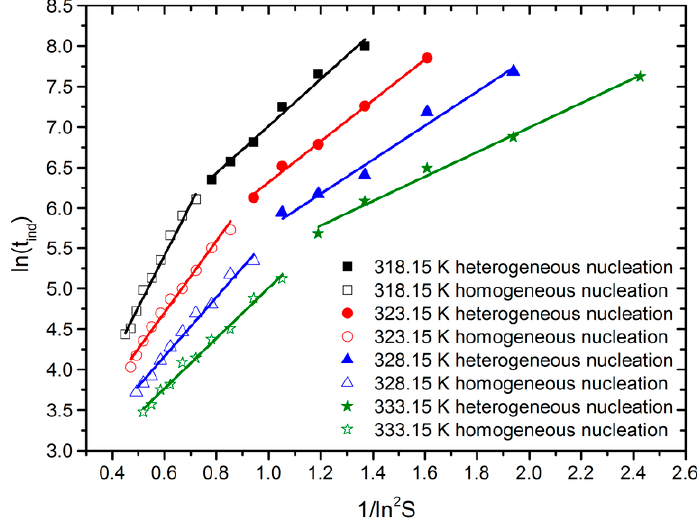
Figure 3. Plot of log(t ind ) versus (logS) − 2 for Li 2 CO 3 crystallization.